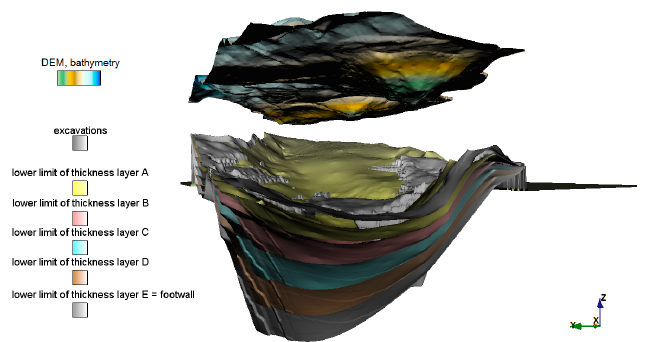
Figure 7. Coal thickness layers and depth of excavations at the VCM.